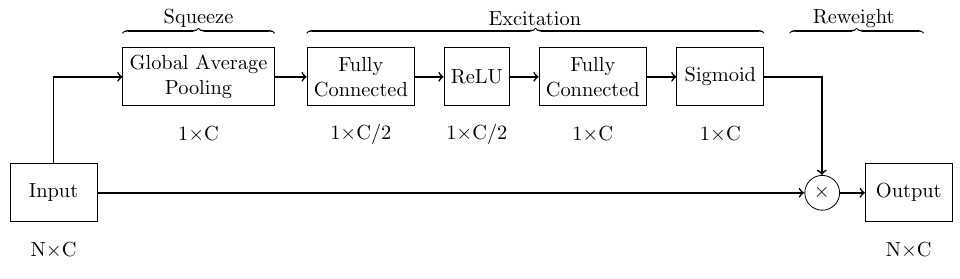
Figure 4. Squeeze and excitation (SE)